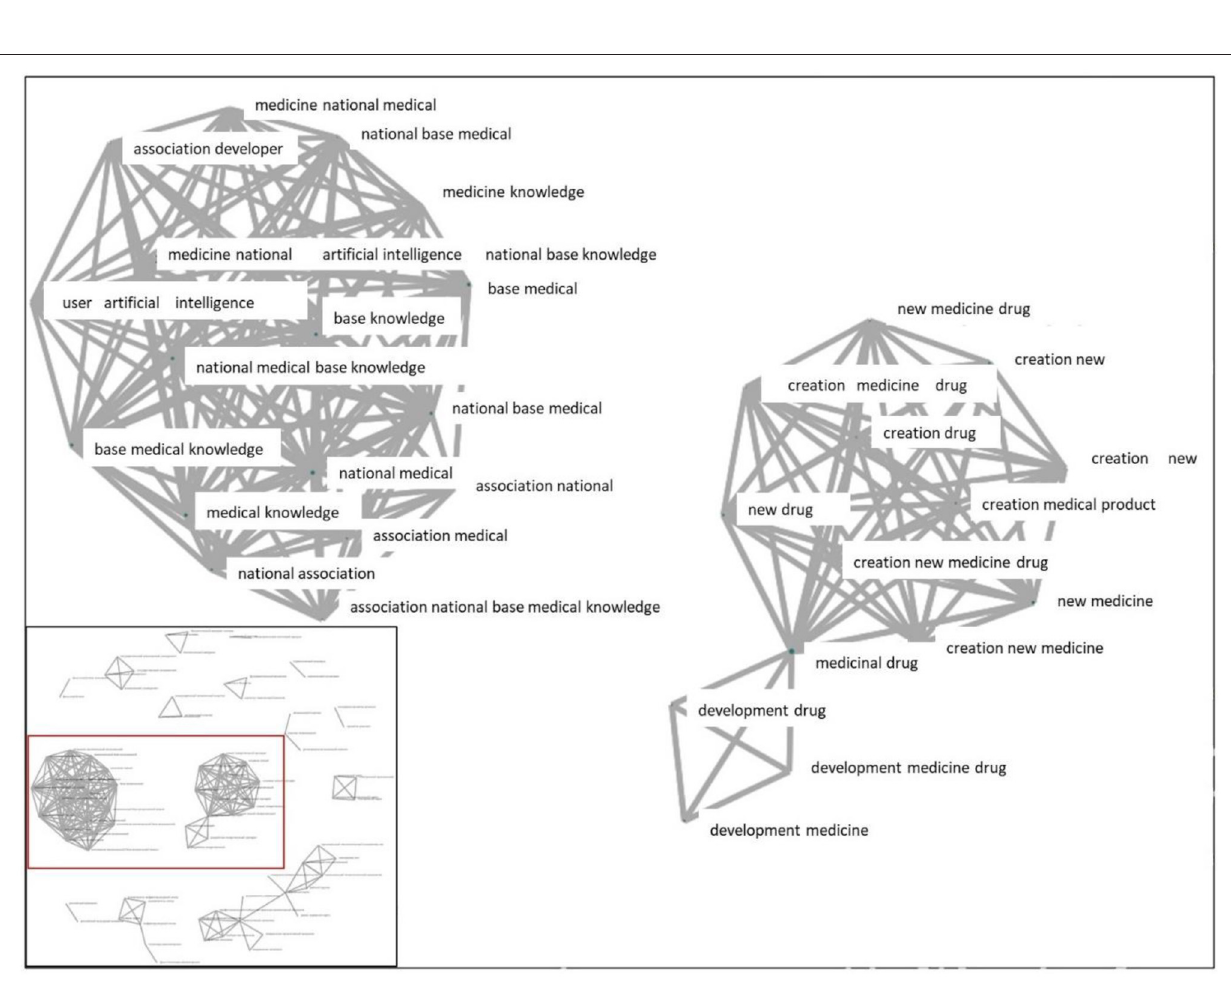
Frontiers in Communication |